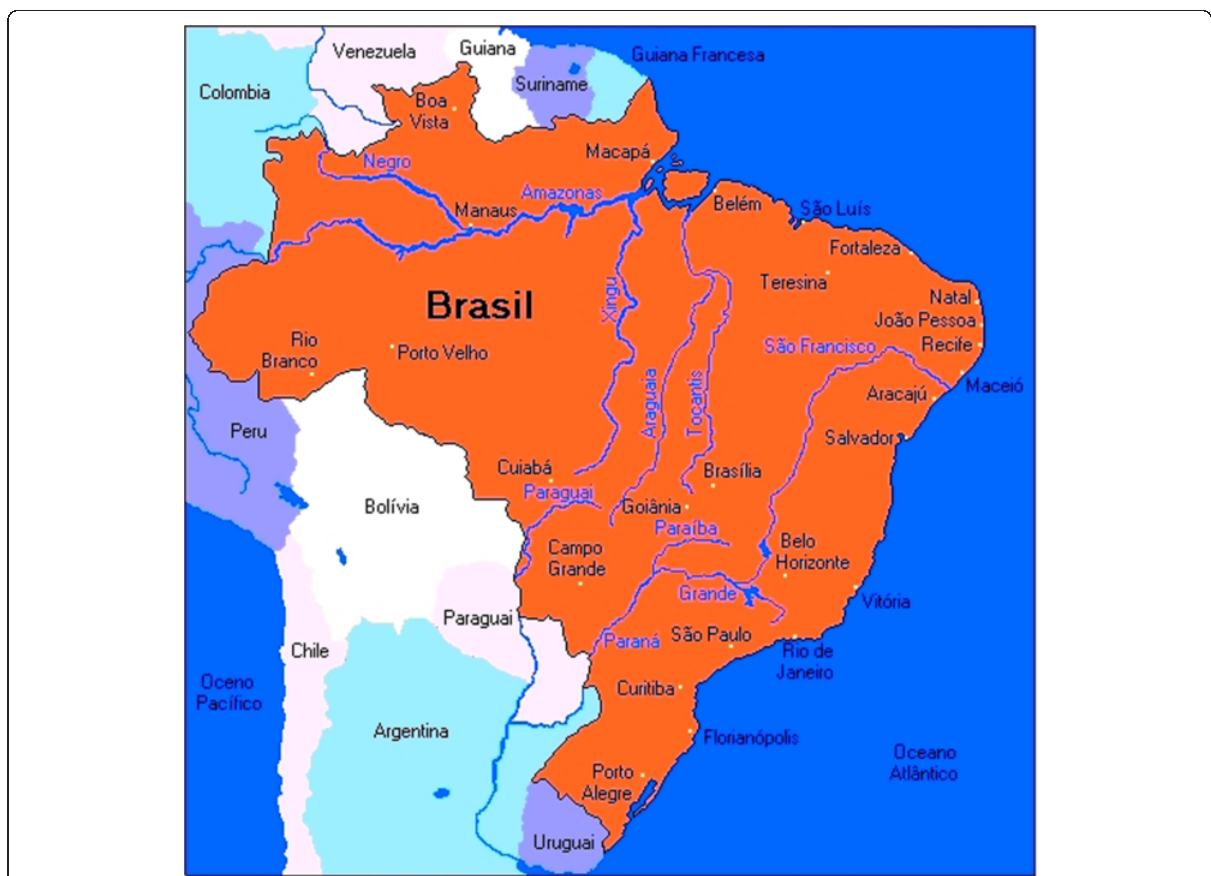
Figure 1 Map of Brazil in South America showing the Atlantic coast and the Amazon, Araguaia-Tocantins and Plata river